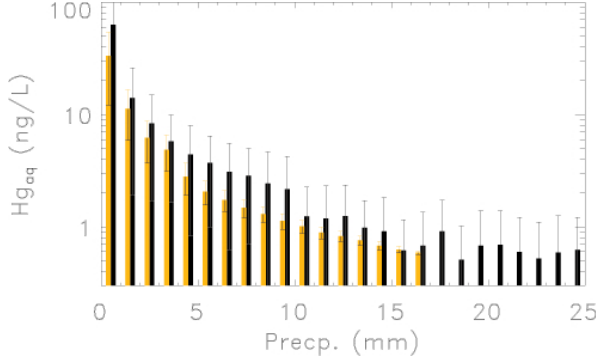
Fig. 13. Domain averaged vertical distribution of (a) hydrometeor in water phase; (b) GOM wet deposition; (c) HgP wet deposition for the stratiform